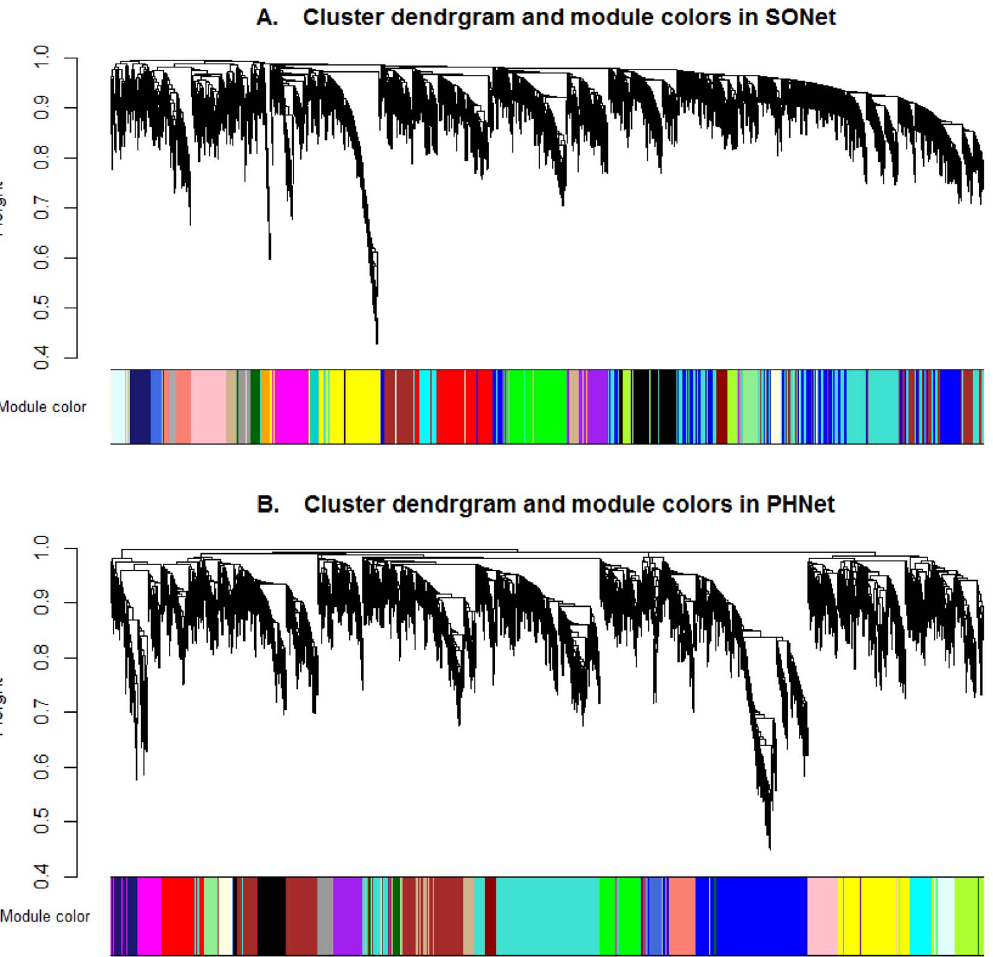
Figure 1. Identification of gene co-expression modules in SONet and PHNet. Hierarchical average linkage clustering was applied to gene- gene adjacencies, which were defined on the basis of TO. Dynamic tree cut algorithm was applied to the dendrogram for module identification, and genes in the same branch could be assigned to different modules. The analysis identified 29 modules (A) and 23 modules (B) represented by different colors on the horizontal bar.